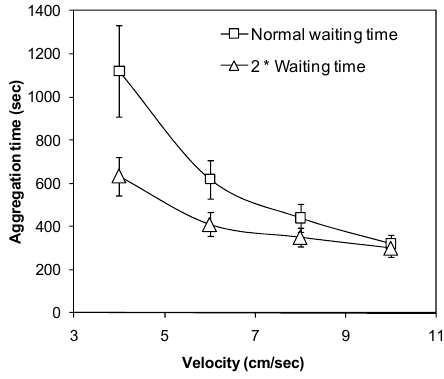
Fig. 9. Aggregation time as a function of velocity with two waiting times